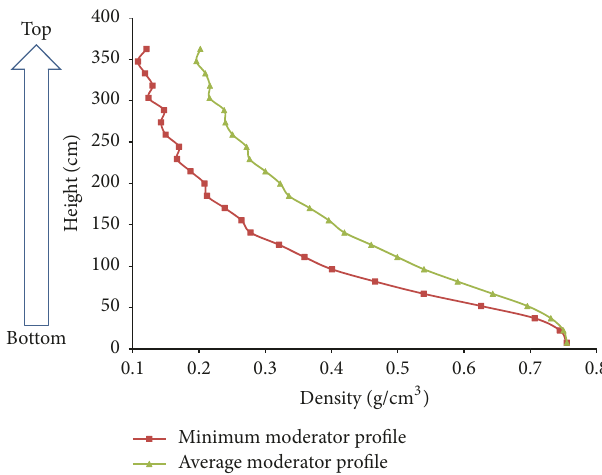
Figure 2: Moderator density profiles.